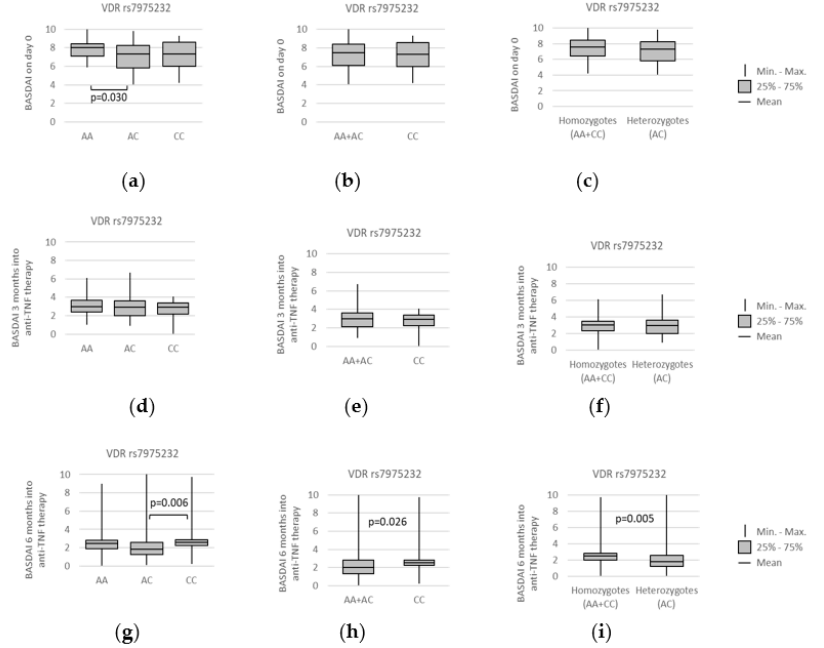
Figure 9. Relationships between and BASDAI scores and VDR rs7975232 genotypes at different time points: ( a – c ) prior to anti-TNF therapy, ( d – f ) after 3 months, and ( g – i ) after 6 months of the treatment. The following statistically significant association was found at day 0: ( a ) AA vs. AC , p = 0.030. Meanwhile, after 6 months into the treatment, the below relations were found: ( g ) AC vs. CC , p = 0.006; ( h ) AA + AC vs. CC , p = 0.026; and ( i ) AA + CC vs. AC , p = 0.005. Analysis was performed using unpaired two-sample Wilcoxon test. Similarly, we observed that after 6 months of anti-TNF treatment the rs7975232 AC Genes 2022 , 13 , x FOR PEER REVIEW genotype was more frequently seen in patients with remission: with BASDAI equal to or lower than 2 (Figure 10). The statistically significant associations were observed within over-dominant model ( AA + CC vs. AC : 15/55 (27.3%) vs. 29/49 (59.2%); p = 0.001) and codominant model ( AC vs. CC : 29/49 (59.2%) vs. 5/29 (17.2%); p < 0.001). Additionally, the presence of the A allele was more common in individuals having BASDAI of 2 or less under the recessive model ( AA + AC vs. CC : 39/75 (52%) vs. 5/29 (17.2%); p = 0.002). Im- portantly, no such observation was made after 3 months of the therapy or prior to anti- TNF treatment (when the BASDAI scores were high and above 4 for all patients).